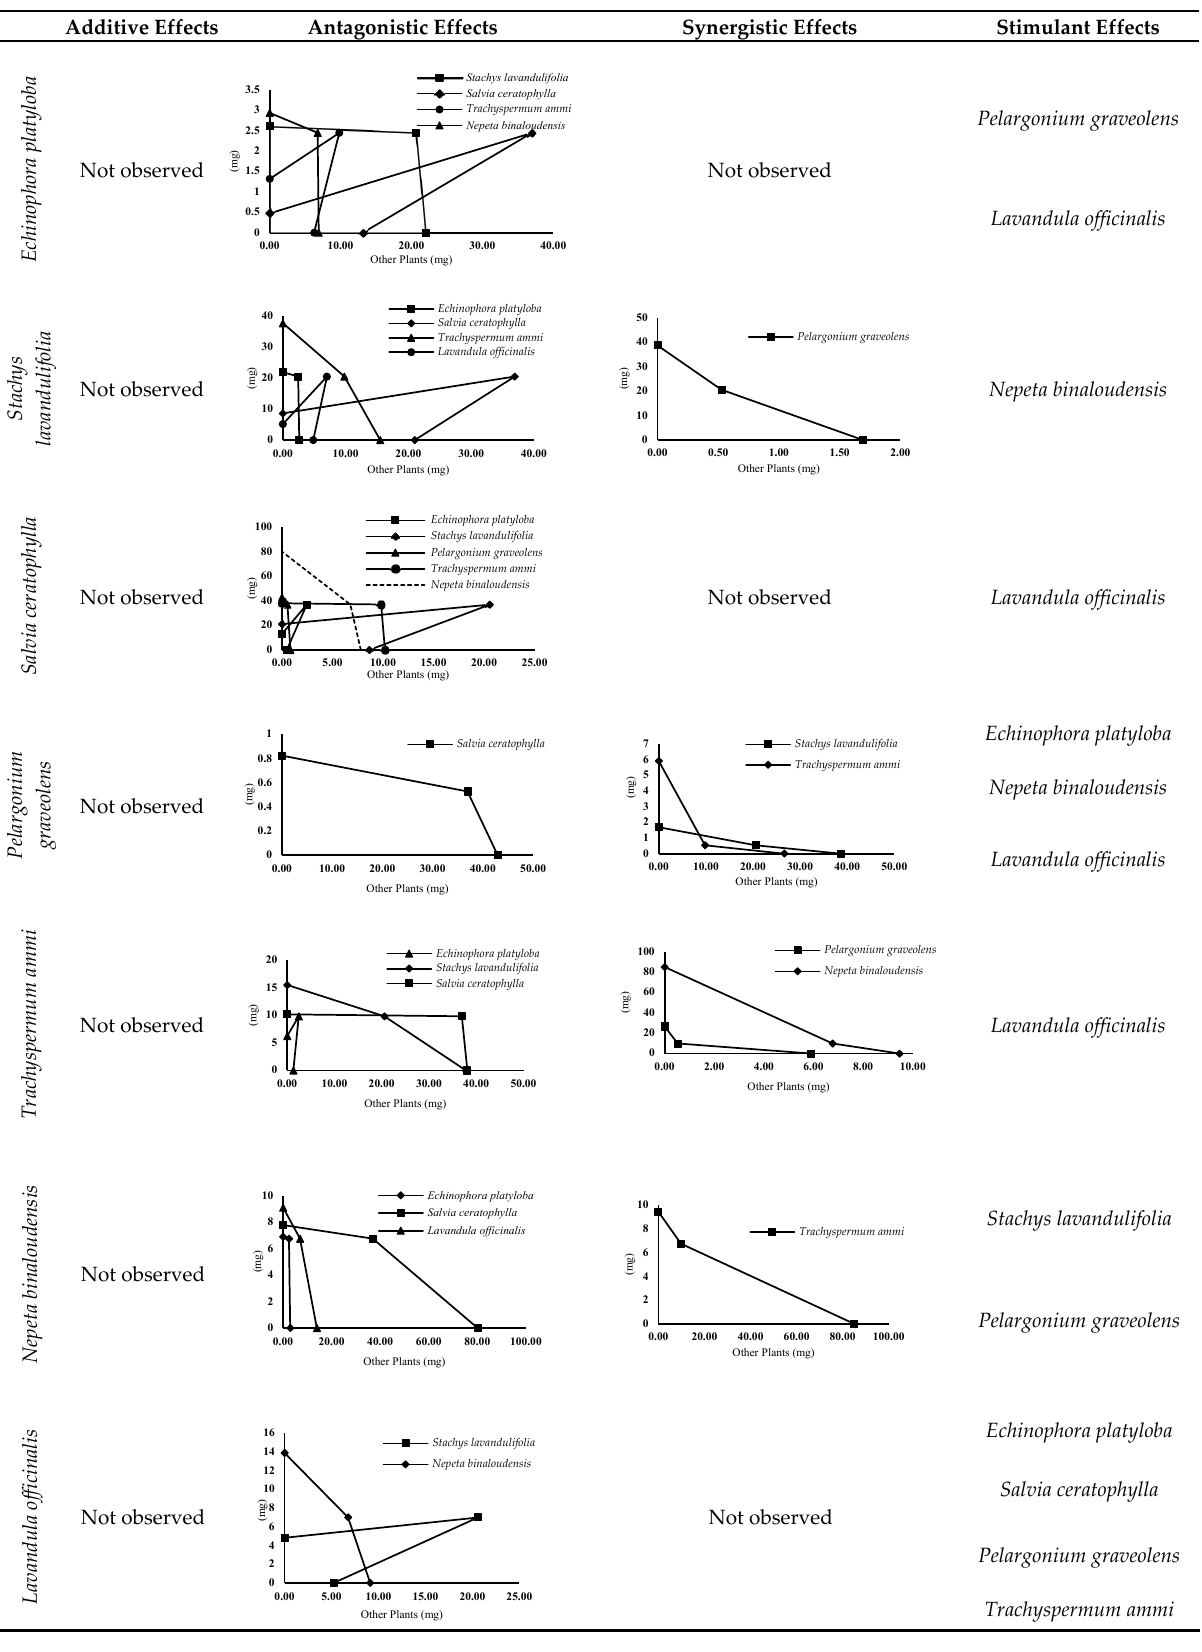
Figure 6. Isobologram curves of allelopathic interaction effects of plants on lettuce radicle growth inhibition.